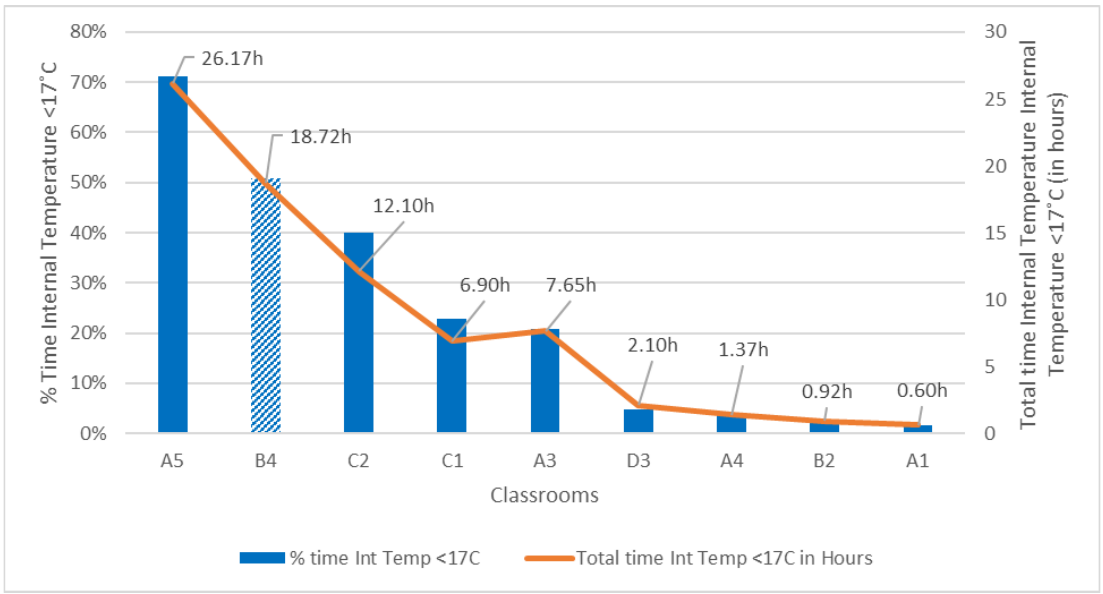
Figure 20. Classrooms with indoor temperature below the 17 °C threshold, with classrooms B1, B4, B5, D1 and D5 having mechanical ventilation.